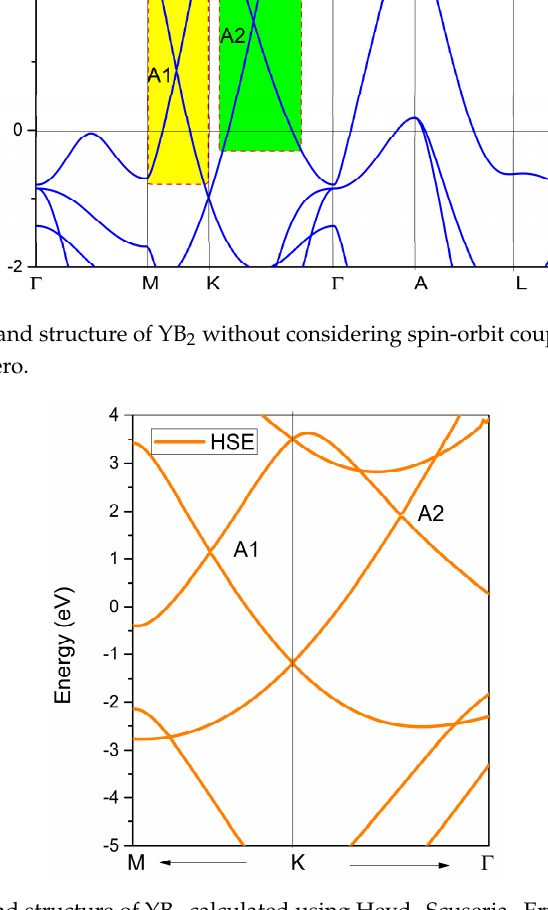
Figure 5. The band structure of YB 2 calculated using Heyd−Scuseria−Ernzerhof (HSE) 06.